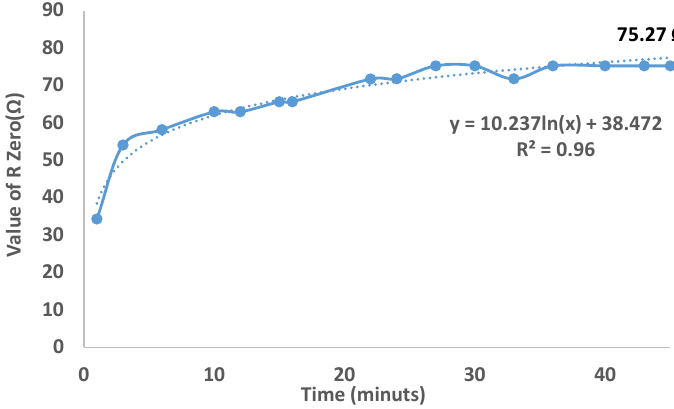
Figure 9. Measurement of R zero obtained after 45 min.